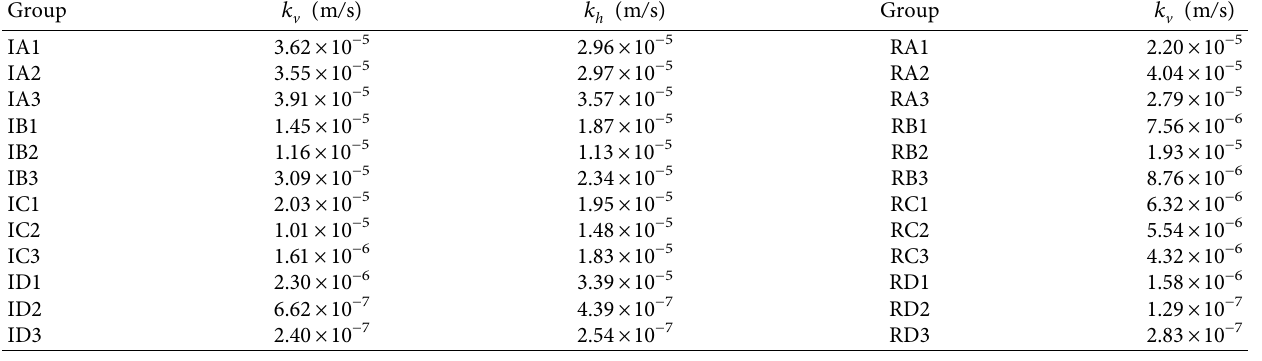
Table 3: Permeability coefficient of samples.